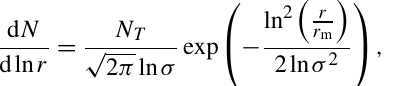
Figure 1. A schematic of changing particle composition in a ris- ing cloud parcel initiated with viscous α -pinene SOA particles, where the water mole fraction of condensed phase particles is given by the colour bar and purple hexagons represent frozen particles in a low-temperature cirrus cloud. Panel (a) is the control model output, which does not take into account condensed phase diffu- sion and (b) is the output from the new bin microphysics cloud model, which includes condensed phase diffusion through individ- ual aerosol